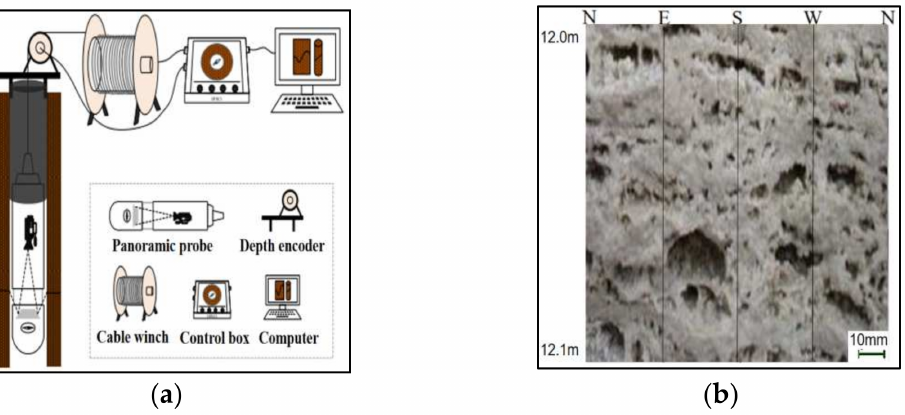
Figure 1. Structural diagram and plan expansion of borehole camera system. ( a ) Structural drawing of borehole camera system; ( b ) Plan expansion of borehole